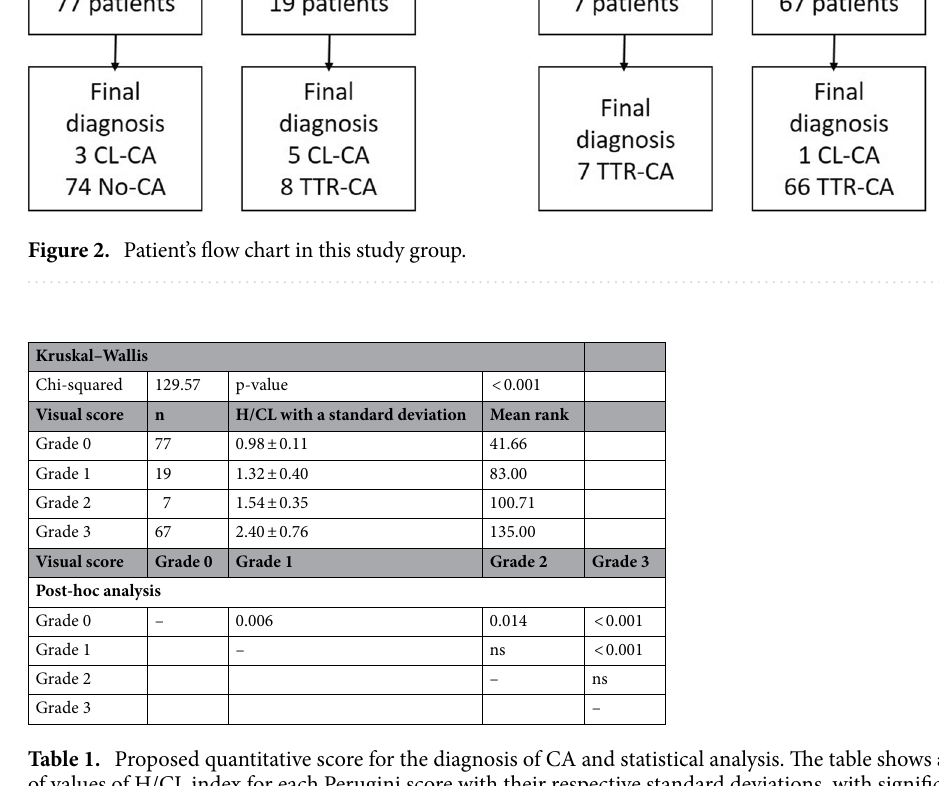
suggestive of TTR-CA, without inconclusive results. In terms of sensitivity and specificity, the optimization of this cut-off value reclassified four patients previously inconclusive into “suggestive of ATTR-CA”, in which the diagnosis was confirmed in 3 cases and was ruled out in one. Table 2 shows the sensitivity and specificity values using different H/CL indices thresholds from grade 1 visual score to reclassify doubtful cases, concluding that a 1.3 threshold has the higher sensitivity (94%) without reducing its specificity (p < 0.05). H/CL ratio (≥ 1.5 suggestive of TTR‑CA and < 1 none‑CA). The current diagnostic algorithm classifies 75 patients (44.1%) as “suggestive of TTR-CA”, of which two patients (2.7%) were finally diagnosed of LC-CA, while the remaining were consistent of TTR-CA by international criteria. Also, 45 patients (26.5%) were classified as inconclusive, of which 8 (17.8%) were TTR-CA, 4 (8.9%) LC-CA, and in the remaining 33 patients (73.3%) CA was ruled out. Finally, this method discarded CA in 50 patients (29.4%), of which 3 (6%) were eventually diag- nosed with LC-CA. H/CL ratio (1.5 vs 1.3 cut‑off value). From the 45 patients classified as inconclusive with a cut-off point of 1.5, the optimized threshold of 1.3 reclassified 4 more patients as “suggestive of TTR-CA”, rejecting the diagnosis in 41 cases. A 1.5 standard threshold presented an 89% sensitivity and 98% specificity, similar to the visual/semi- quantitative evaluation. Still, when a 1.3 threshold is used, the sensitivity increases to 94% without reducing its specificity, with statistically significant differences (Fig. 5).